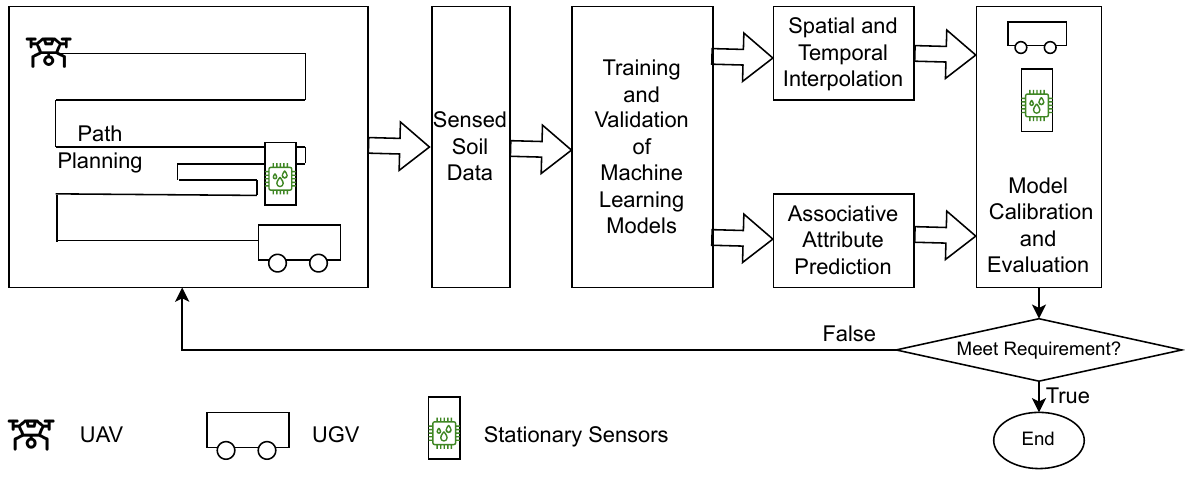
Figure 1. Model-driven sensing framework with heterogeneous sensor networks and active